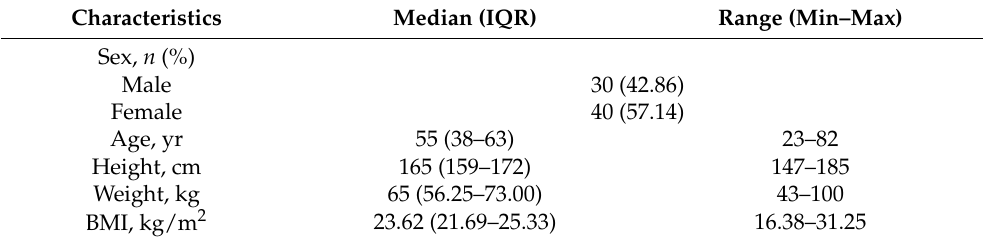
Table 2. Patient demographic and anthropometric characteristics ( n =